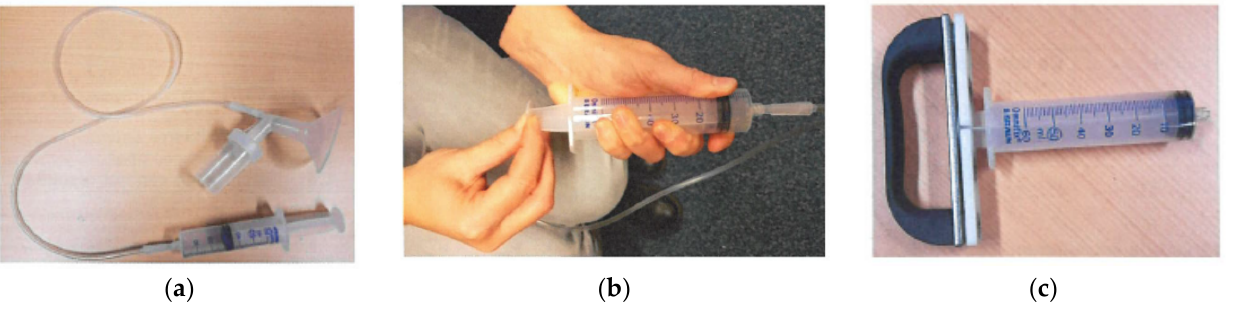
Figure 3. Pictures of materials used for manual nipple fluid aspiration procedure. ( a ) Interconnection with a plastic tube between the cup that is placed on the breast around the nipple and a syringe; ( b ) figure of the research nurse showing how to grasp the plunger of the syringe to create vacuum. ( c ) Ergonomic handle that we developed to attach to the plunger of the syringe.